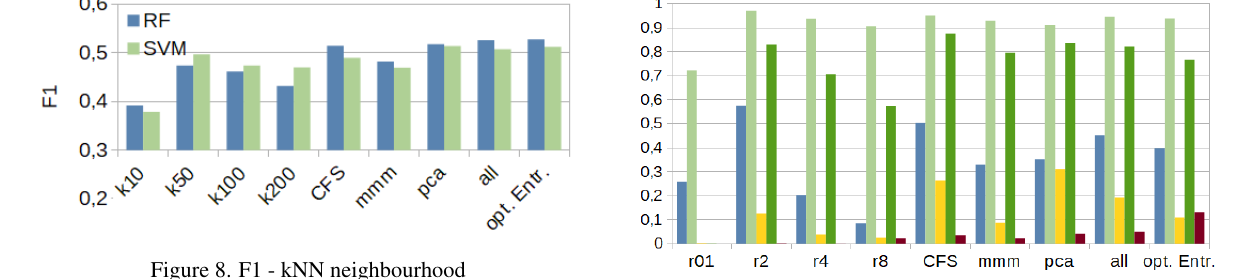
Figure 8. F1 - kNN neighbourhood